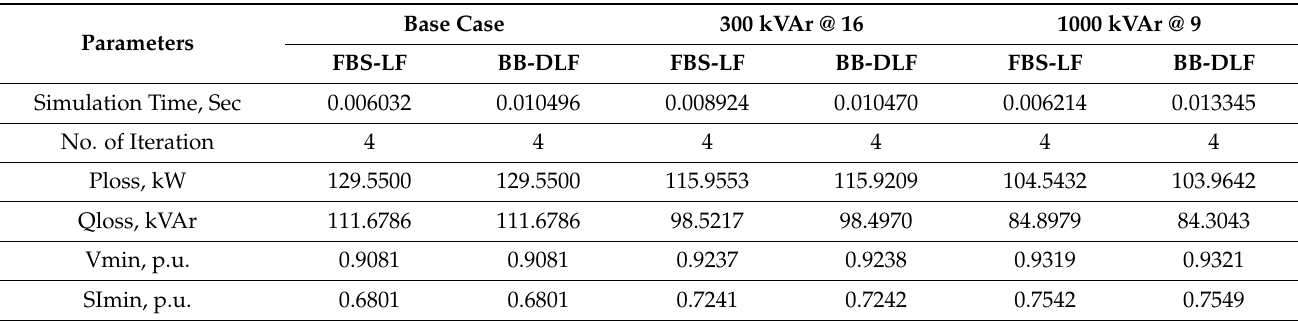
Table 2. Comparison of Performance of Load Flow for incorporation of proposed D-STATCOM Modeling into 51-Bus